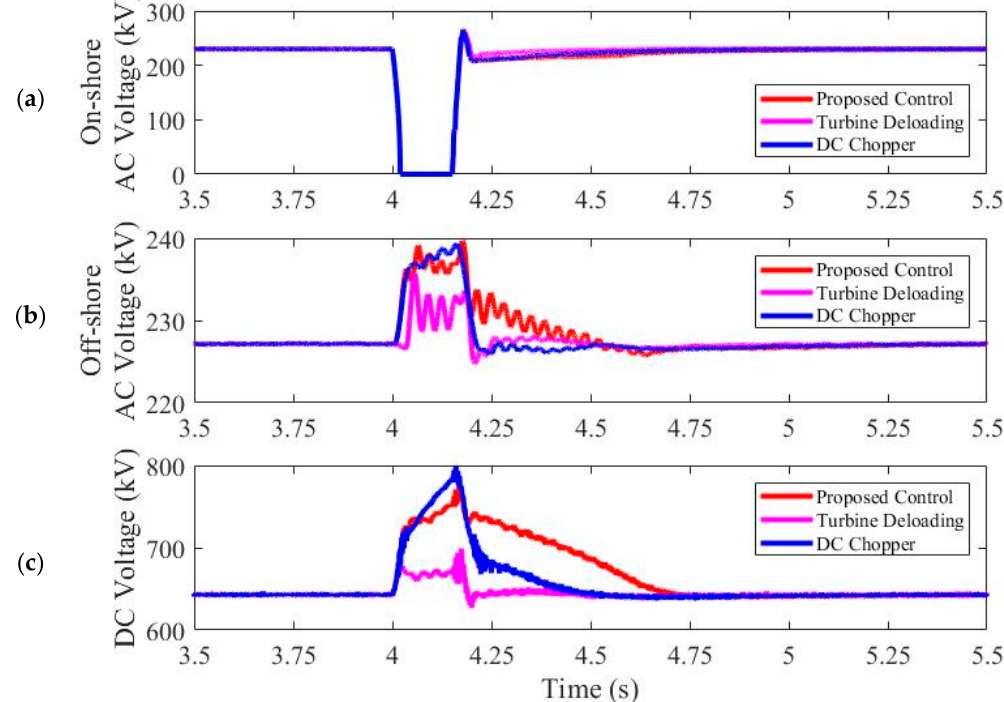
Figure 7. Simulation results of the on-shore fault scenario with 0.001 Ω fault resistance. ( a ) On-shore AC voltage for each simulation case. ( b ) Off-shore AC voltage for each simulation case. ( c ) Rectifier-side DC voltage for each simulation case.